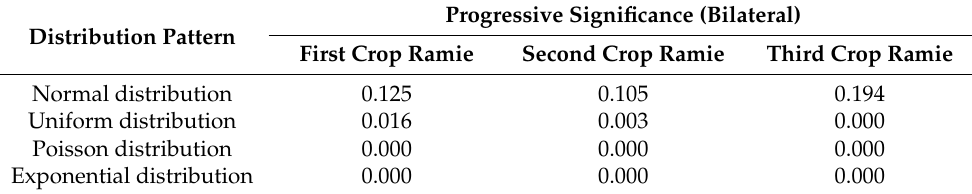
Table 2. Significance result of Kolmogorov–Smirnov